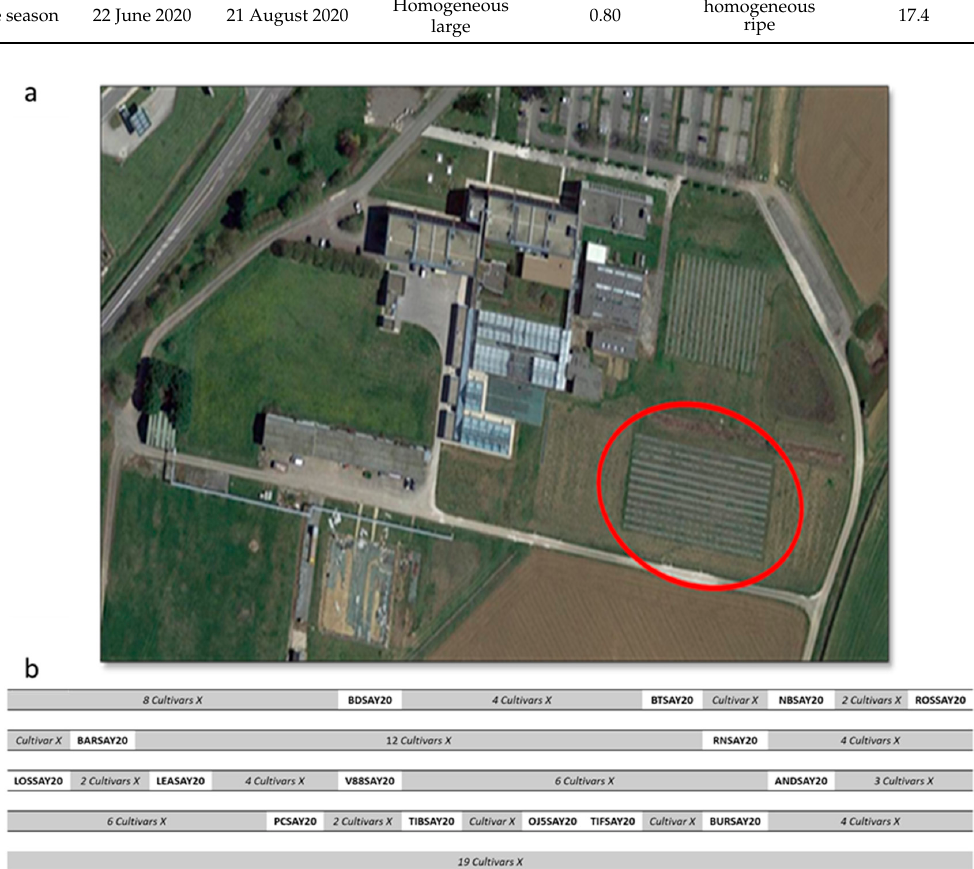
Figure 5. Cultivars and growing areas. ( a ) Aerial view of the Sayens site of Agronov, Agricultural Chamber of Burgundy, Bretenières, France. The red circle indicates the plot where the fifteen blackcurrant cultivars were grown; ( b ) the organization of the plot. “Cultivars X” refers to other cultivars from the Sayens collection that were not taken into account in the present study. All plants were about six years old and were pruned each year in winter around Jan- uary (only dead and obstructing branches were cut). Each blackcurrant plant received fer- tilizers (nitrogen, potassium, magnesium, and phosphorus) but not watering or chemical weeding. 3.2. Berry Harvesting and Storage The fifteen cultivars of blackcurrant were harvested at maturity. Three conditions had to be met for the fruit to be considered ripe: the berries had to be easy to pick, they had to color the skin when crushed between two fingers, and the total soluble solids con- centration (°Brix) at harvest had to be over 15°. As all the cultivars ripened at different times (early ripening, middle-season ripening, or late ripening), the harvesting period ex- tended over one month from June to the beginning of July, as indicated in Table 3. All the berries of each plant were manually picked and pooled together for the same cultivar. Cultivars gave berries of different sizes, ranging from 31 to 99 g/100 berries, with 38 g/100 berries for Noir de Bourgogne. Berries were stored frozen ( − 40 °C) until analysis. The du- ration of storage ranged from one to three months (Table 3). 3.3. Analysis of the Volatile Fraction of Berries 3.3.1. HS-SPME-GC-MS Volatiles were extracted with 1 cm SPME DVB/CAR/PDMS (divi-nylbenzene/car- boxen/polydimethylsiloxane; 50/30 μ m) fiber. The fiber (24 Ga 50/30 μ m, for manual